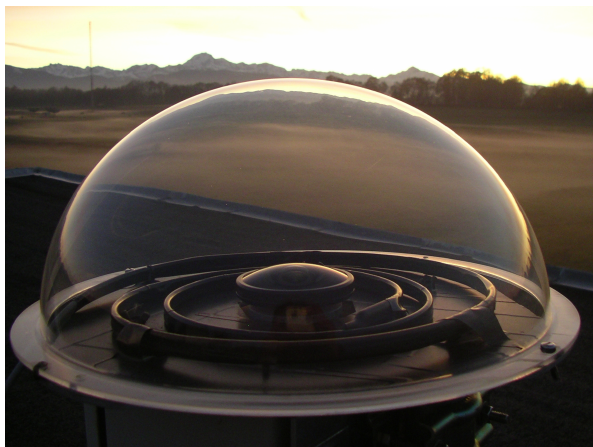
Figure 1. The RAPACE sky imager system developed at the P2OA instrumented site. We can see the fish-eye lens at the center, the Plexiglas dome, and the thermostatted heating wire in a spiral around the